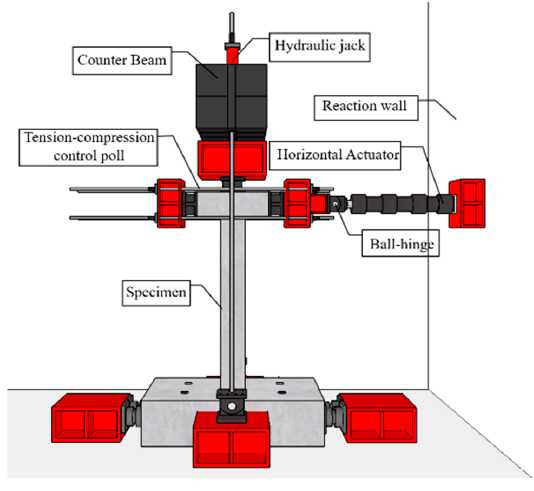
Figure 4. Test setup.